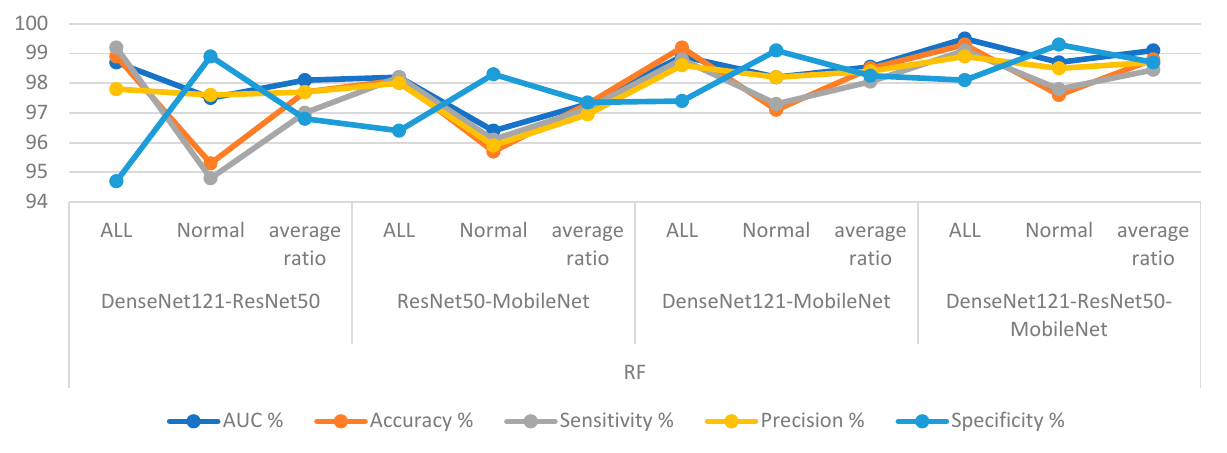
Figure 14. Display of results of the RF and XGBoost classifiers based on fusion features of the CNN models of the C-NMC 2019 dataset for the diagnosis of acute leukemia.